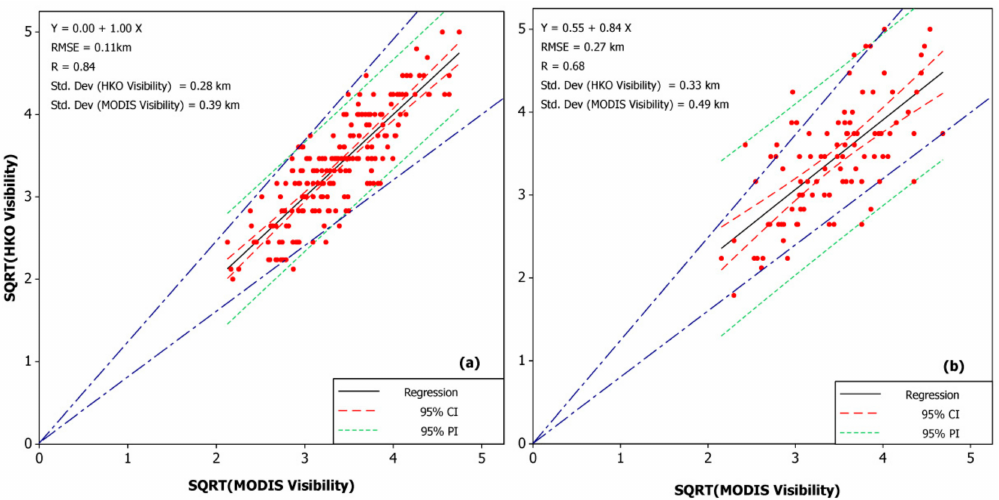
Figure 12. Correlation between Square root of MODIS visibility at HKO (SQRT (MODIS Visibility)) and Square root of ground visibility at HKO (SQRT (HKO Visibility)) using M2 ( a ) linear multiple regression of training data for the years 2005 to 2007; ( b ) simulated MODIS visibility using validation of data (MODIS AOD and Climatic data) from years 2008. Blue dotted dashed lines show the upper and lower limit of ± 20% of the ground visibility at HKO, whereas black solid line is the resultant regression